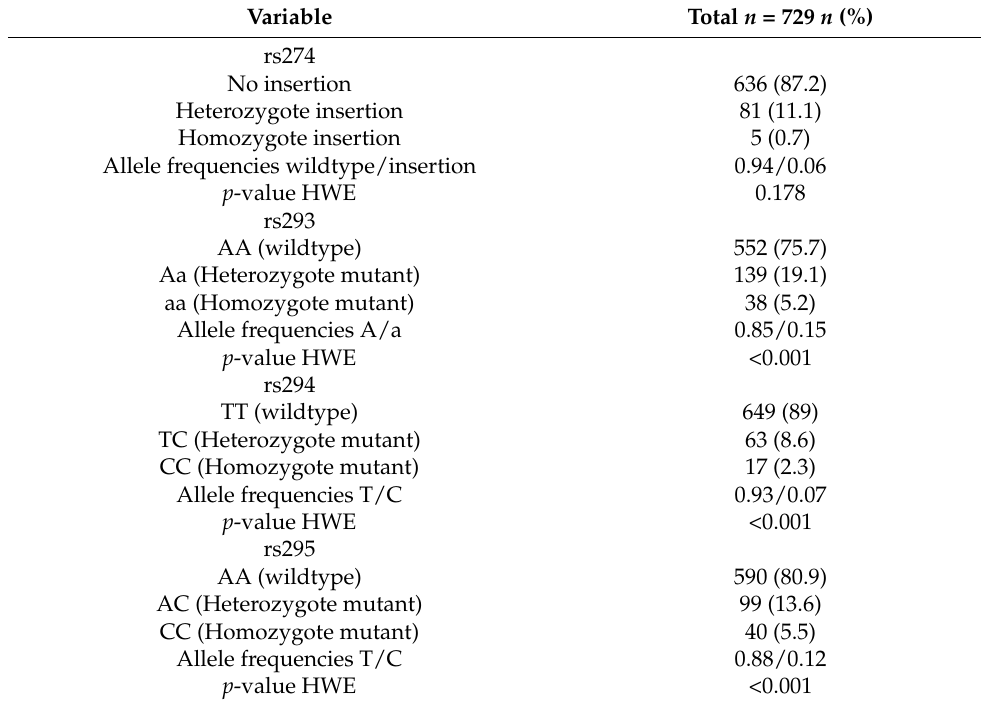
Table 3. A summary of the observed genotypes, allele frequencies, p -value and HWE for the four variations, c.1019-685_1019-684insA (rs293), c.1018+382_1018+383insT or c.1018+386_1018+387insA